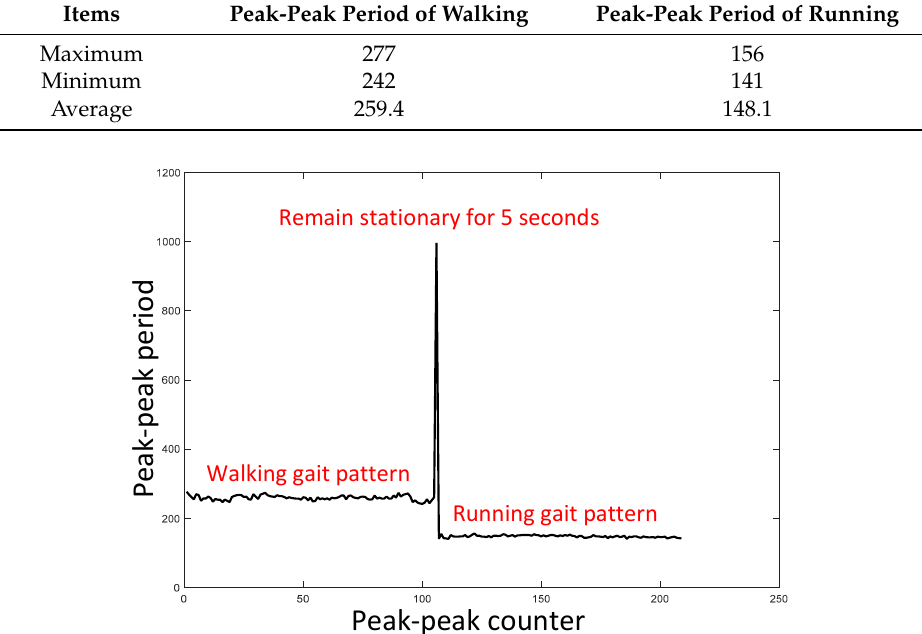
Figure 13 . Using peak-peak time period information to distinguish walking/running gait pattern.